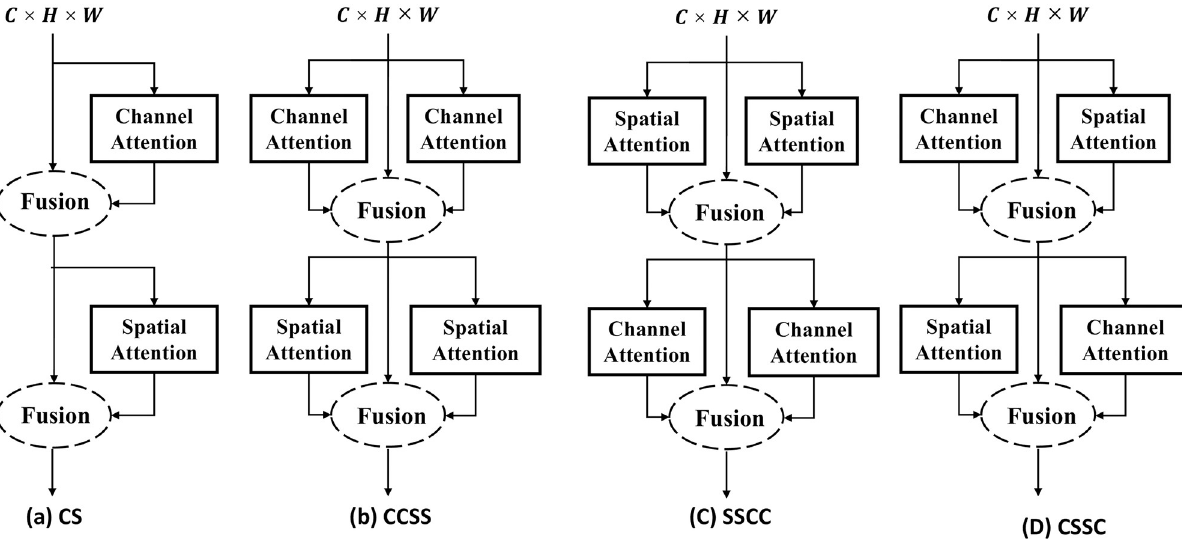
Fig 3. Structure comparison of the different order of channel and spatial attention. (a) is CBAM attention mechanism including a channel attention and spatial attention mechanism. (b) is the mechanism of two channel followed by two spatial attentions. (c) is the mechanism of two spatial attentions followed by two channel attentions. (d) is our CRCBAM attention